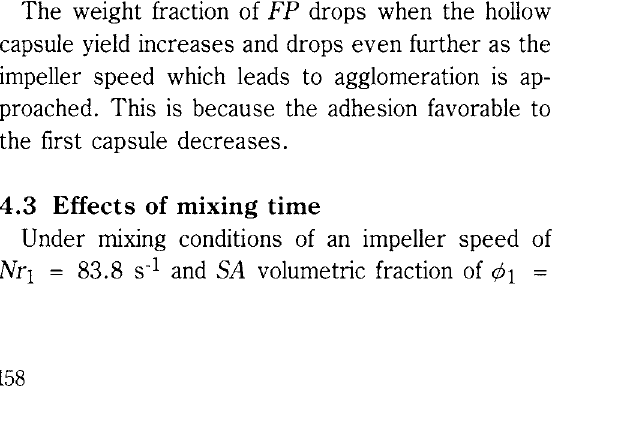
Fig. 13 Effect of the mixing time on the mean size